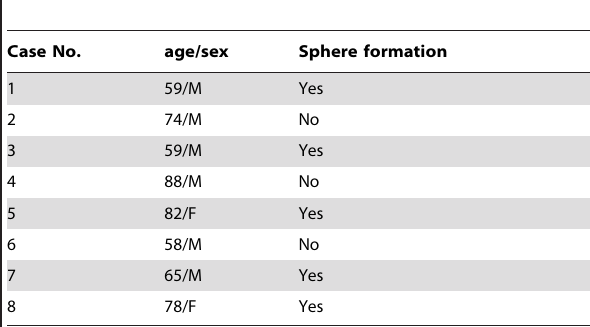
Table 7. The ability of sphere formation of primary culture cells from MPE.